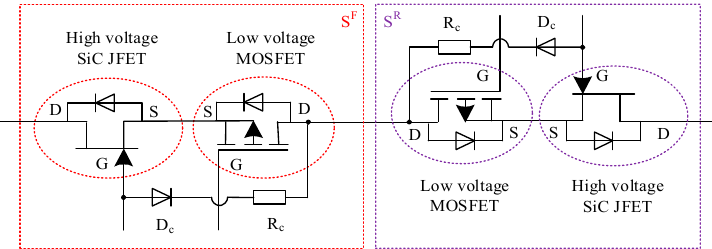
Figure 1. The developed structure of the SiC JFET-based BDS using two anti-serial cascode-light